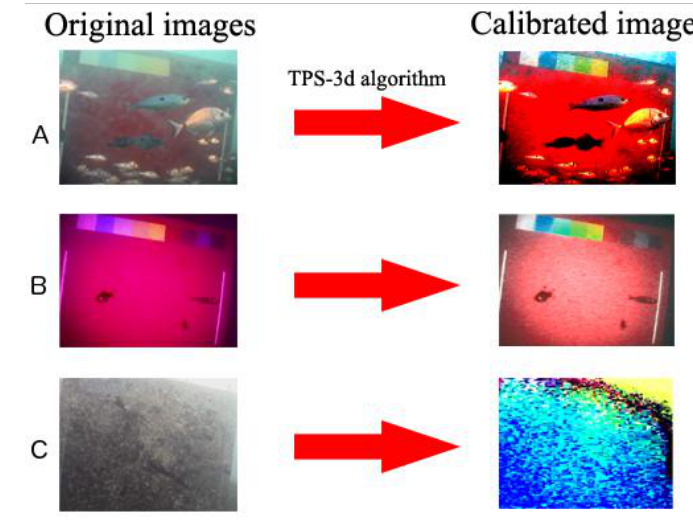
Figure 3. Example of three images with different illumination conditions ( A , day, B , night; C , day with turbidity), before and after the